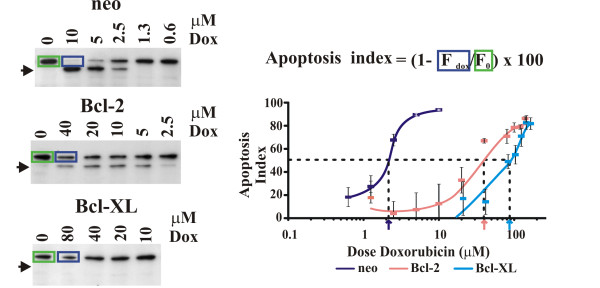
Quantitative determination of PARP cleavage and degradation in MCF-7 cells following induction of apoptosis by treatment with doxorubicin. The left panel shows the results of vector transfected (Neo) (top), Bcl-2 (middle) and Bcl-XL (bottom) expressing MCF-7 cells treated for 48 hours with increasing doses of doxorubicin as indicated, and cell lysates immunoblotted for PARP. The migration position of the 89 kDa PARP fragment diagnostic of caspase cleavage is indicated to the left of the blots (arrow). The antibody used for immunoblotting does not recognize cleavage products generated by other proteases activated during apoptosis. Therefore, both PARP cleavage and degradation were combined into a single apoptosis index (right panel, top) determined by measuring the band intensities for the116 kDa full length PARP in untreated cells (green box, 0), and in cells treated with doxorubicin (e.g. blue box) for the dose indicated above the lanes, on a Kodak image station. Actin blots were used to demonstrate equal protein loading in each lane (Figure 6). This index is plotted versus dose of doxorubicin for vector transfected cells (neo), and for cells expressing 3.6 ng Bcl-2 and 0.9 ng Bcl-XL per μg of total cell protein, respectively (right panel, bottom). EC50 values determined from the resulting dose response curves are indicated with coloured upward arrows.